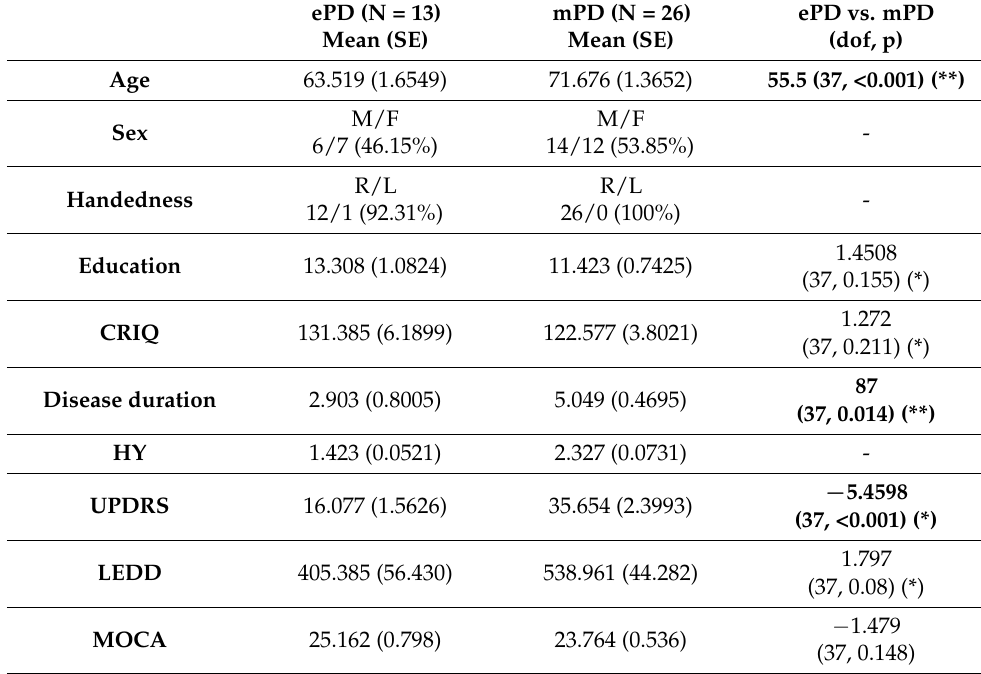
Table 1. Patient’s characteristics and clinical variables with respect to the ePD group and the mPD group. Differences in participant characteristics were assessed either by (*) independent sample t -test or (**) the Mann–Whitney U-test, depending on data distribution. The clinical variables included the Cognitive Reserve Index questionnaire (CRIQ); the Hoehn and Yahr scale (HY); the Montreal Cognitive Assessment (MOCA); the Levodopa Equivalent Daily Dose (LEDD); the Unified Parkinson’s Disease Rating Scale (UPDRS); the Stroop Color and Word error score (SCWE); the Stroop Color and Word time score (SCWT); and the 5-level EQ5D5L scale (EQ5D5L). Bold highlights significant